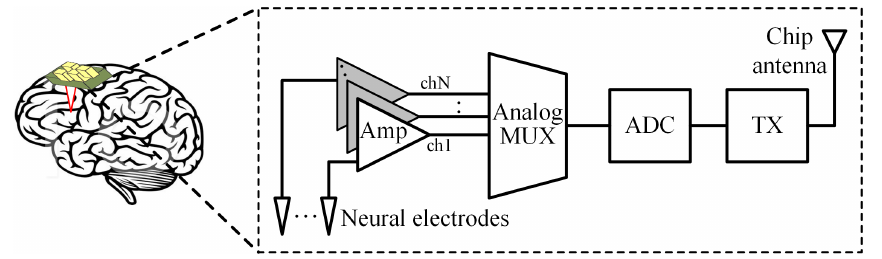
Figure 1. Overview of the neural signal recording system for brain neuromodulation